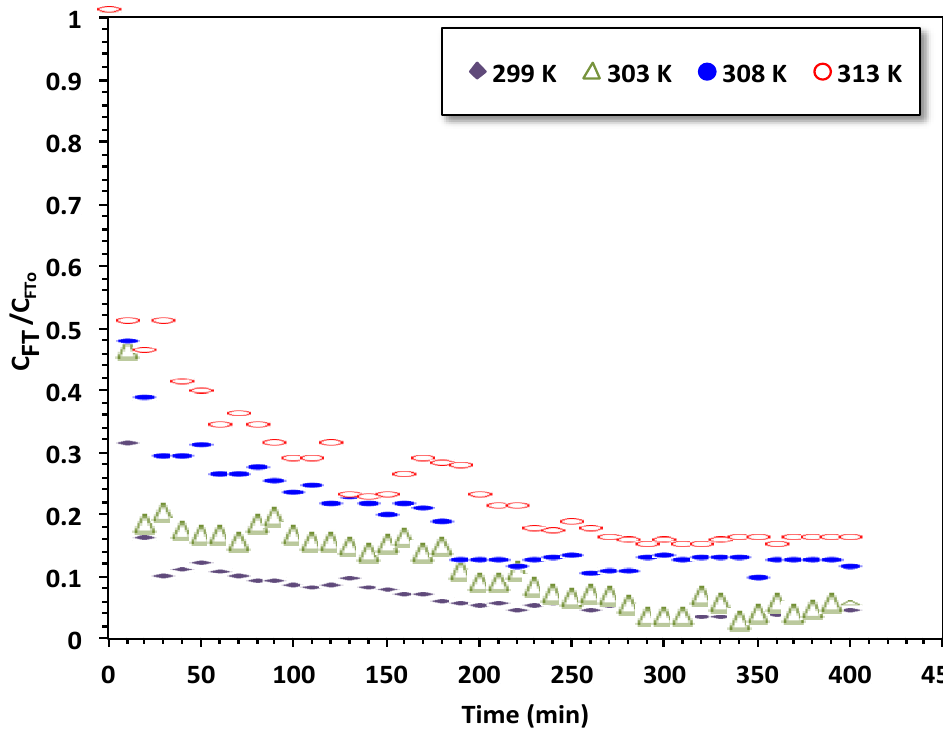
Figure 8. Effect of aqueous Flytek pesticide effluent temperature on the uptake removals.